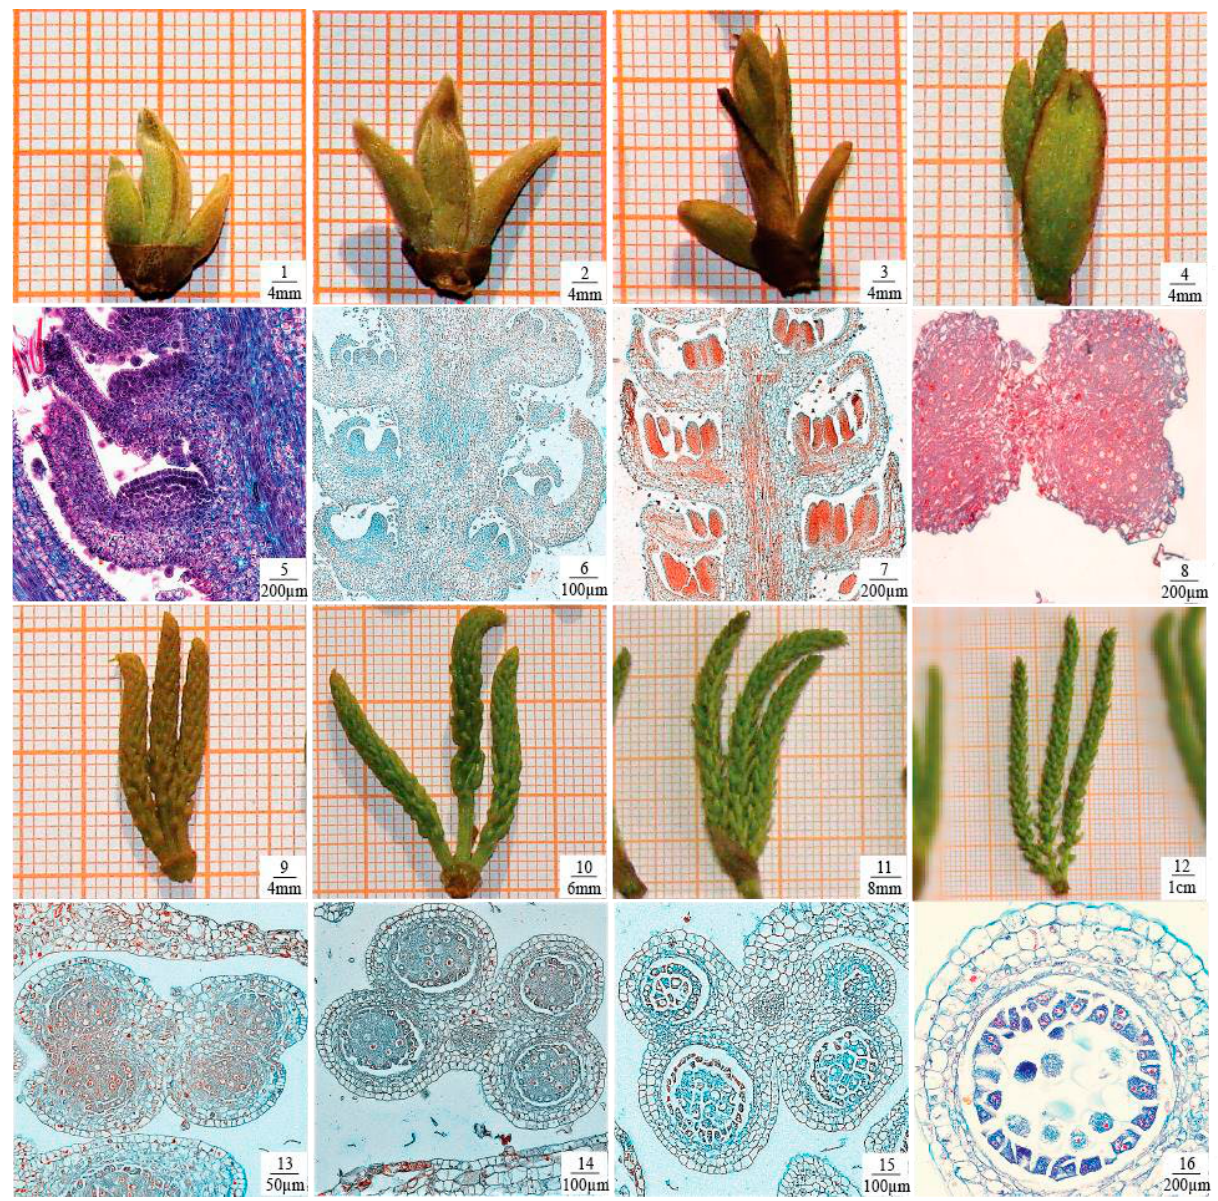
Figure 2. Internal and external structure of bud and staminate flower differentiation in pecan. 1) Staminate flower buds elongated and swol- len. 2) Staminate flower buds elongating in bracts. 3) Leaves separation. 4) Side bracts cracking and staminate inflorescences extending. 5) Floret primordium expansion. 6) Bracteole differentiation. 7) Pollen sac elongation. 8) Secondary sporogenous cell differentiation. 9)